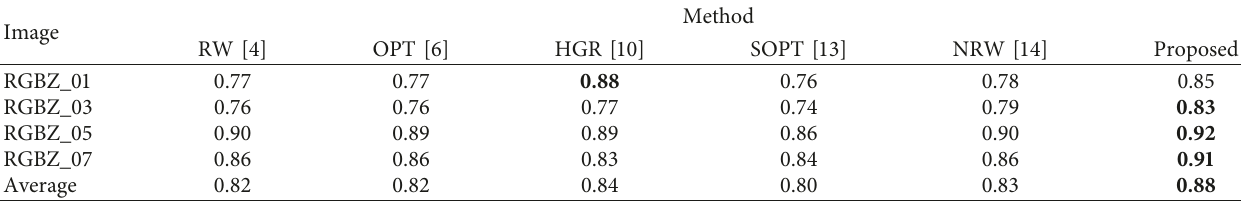
Table 3: SSIM comparison in the presence of inaccurate scribbles.